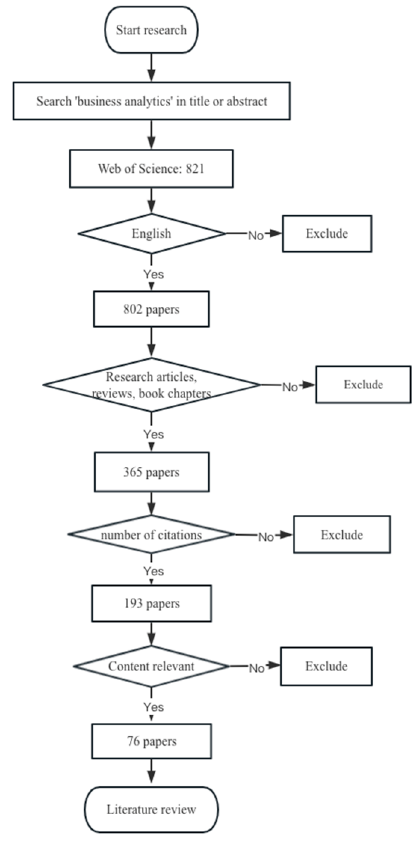
Figure 1. Process of selection.